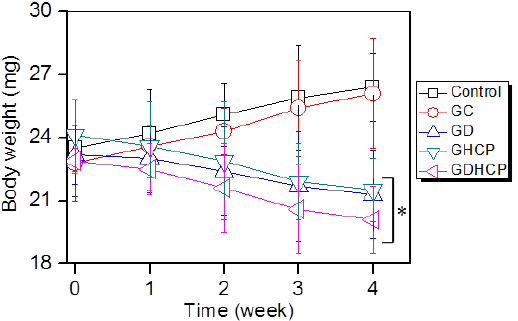
Figure 5. Body weights of control, GC-, GD-, GHCP- and GDHCP-treated mice measured at 1, 2, 3 and 4 weeks. This experiment was performed three times (* p < 0.05). The significance was compared with the control.